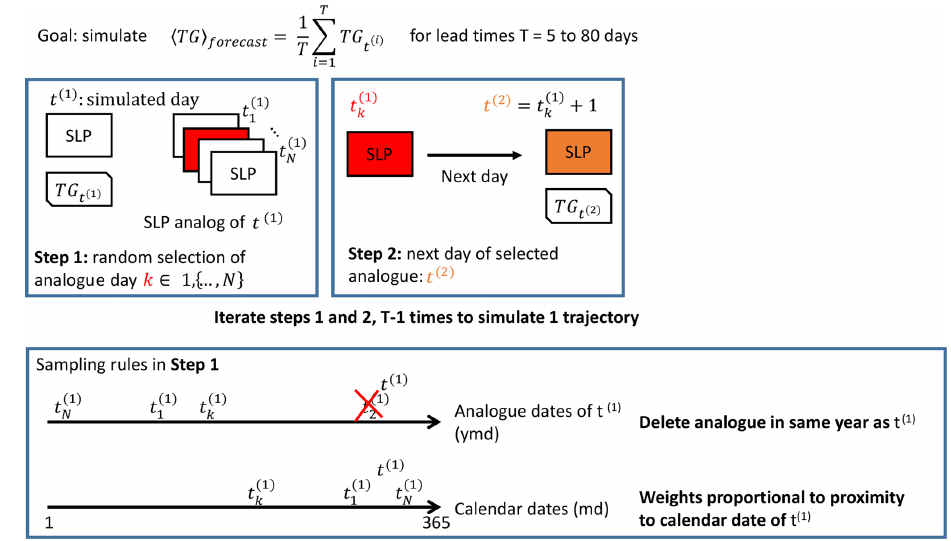
Figure 2. Schematic of the iteration procedure to simulate one random trajectory of temperature (TG) from SLP analogues. The values of t (k) are the days to be simulated by the system. The values of t (k) randomly selected analogues according to the rule defined in the lower box. This procedure is repeated S times to generate an ensemble of